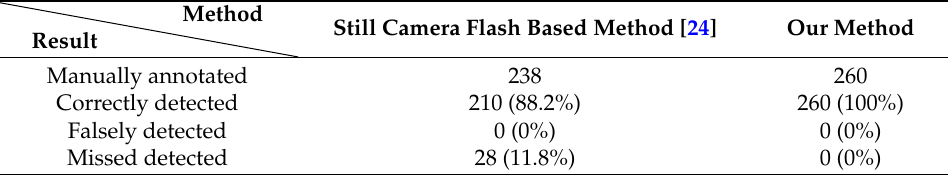
Table 1. Results of synchronization signal